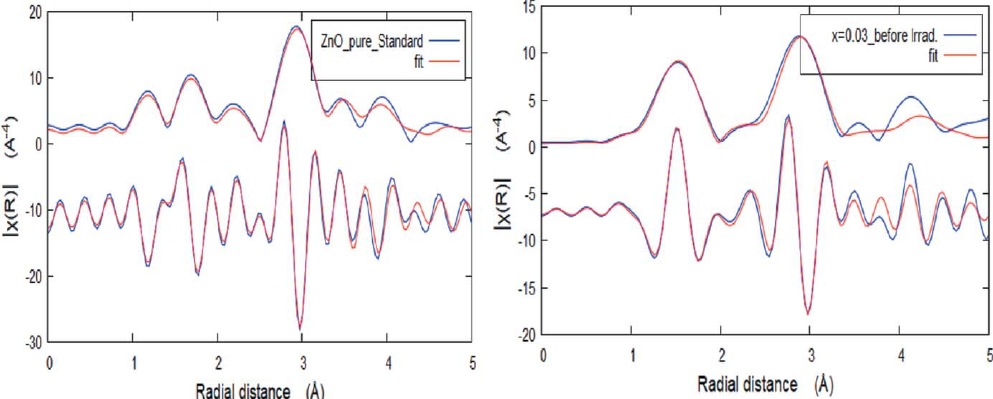
Figure 4 Examples of the EXAFS fit obtained for the FT magnitude and the imaginary part of the EXAFS signal at x = 0.0 and